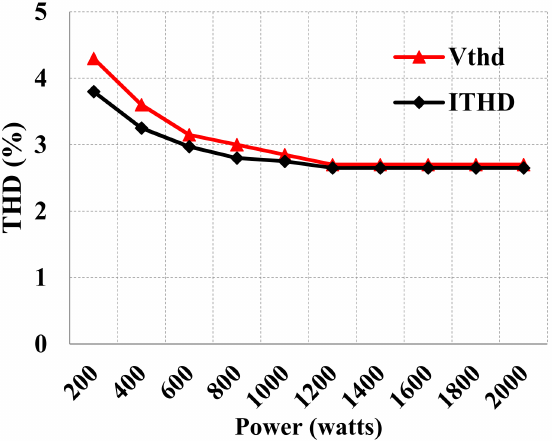
Figure 14. Voltage and current harmonics at various RL load.